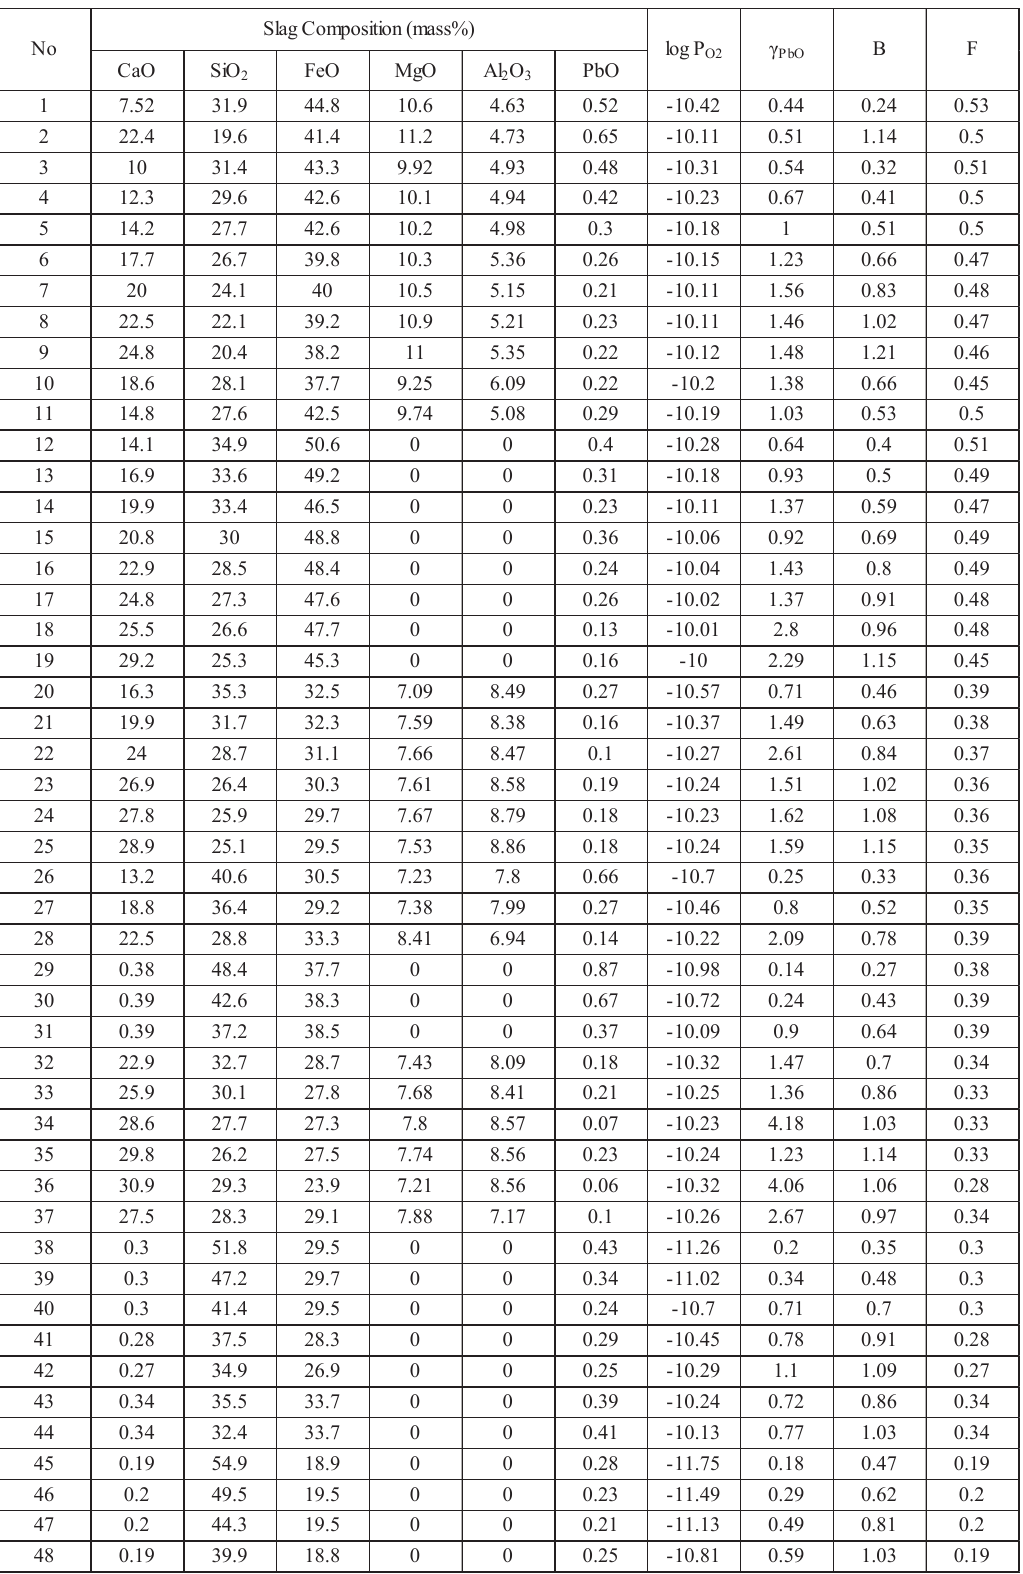
Table 2. Equilibrium composition of the slag with pure liquid